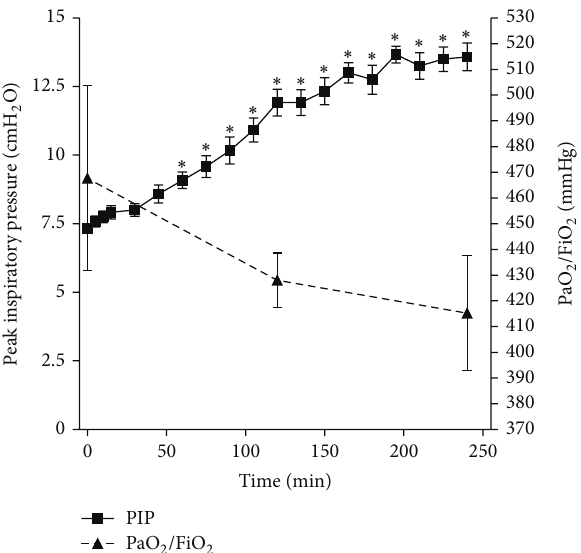
Figure 5: Physiological parameters during in vivo ventilation. Peak inspiratory pressure (PIP) (solid line, left axis) was determined every 15 minutes; arterial partial pressure of oxygen over fraction of inspired oxygen (PaO 2 /FiO 2 ) (dashed line, right axis) was determined at time 0, 120, and 240 minutes of in vivo mechanical ventilation. ∗ 𝑃 < 0.05 versus time 0, ± SEM.